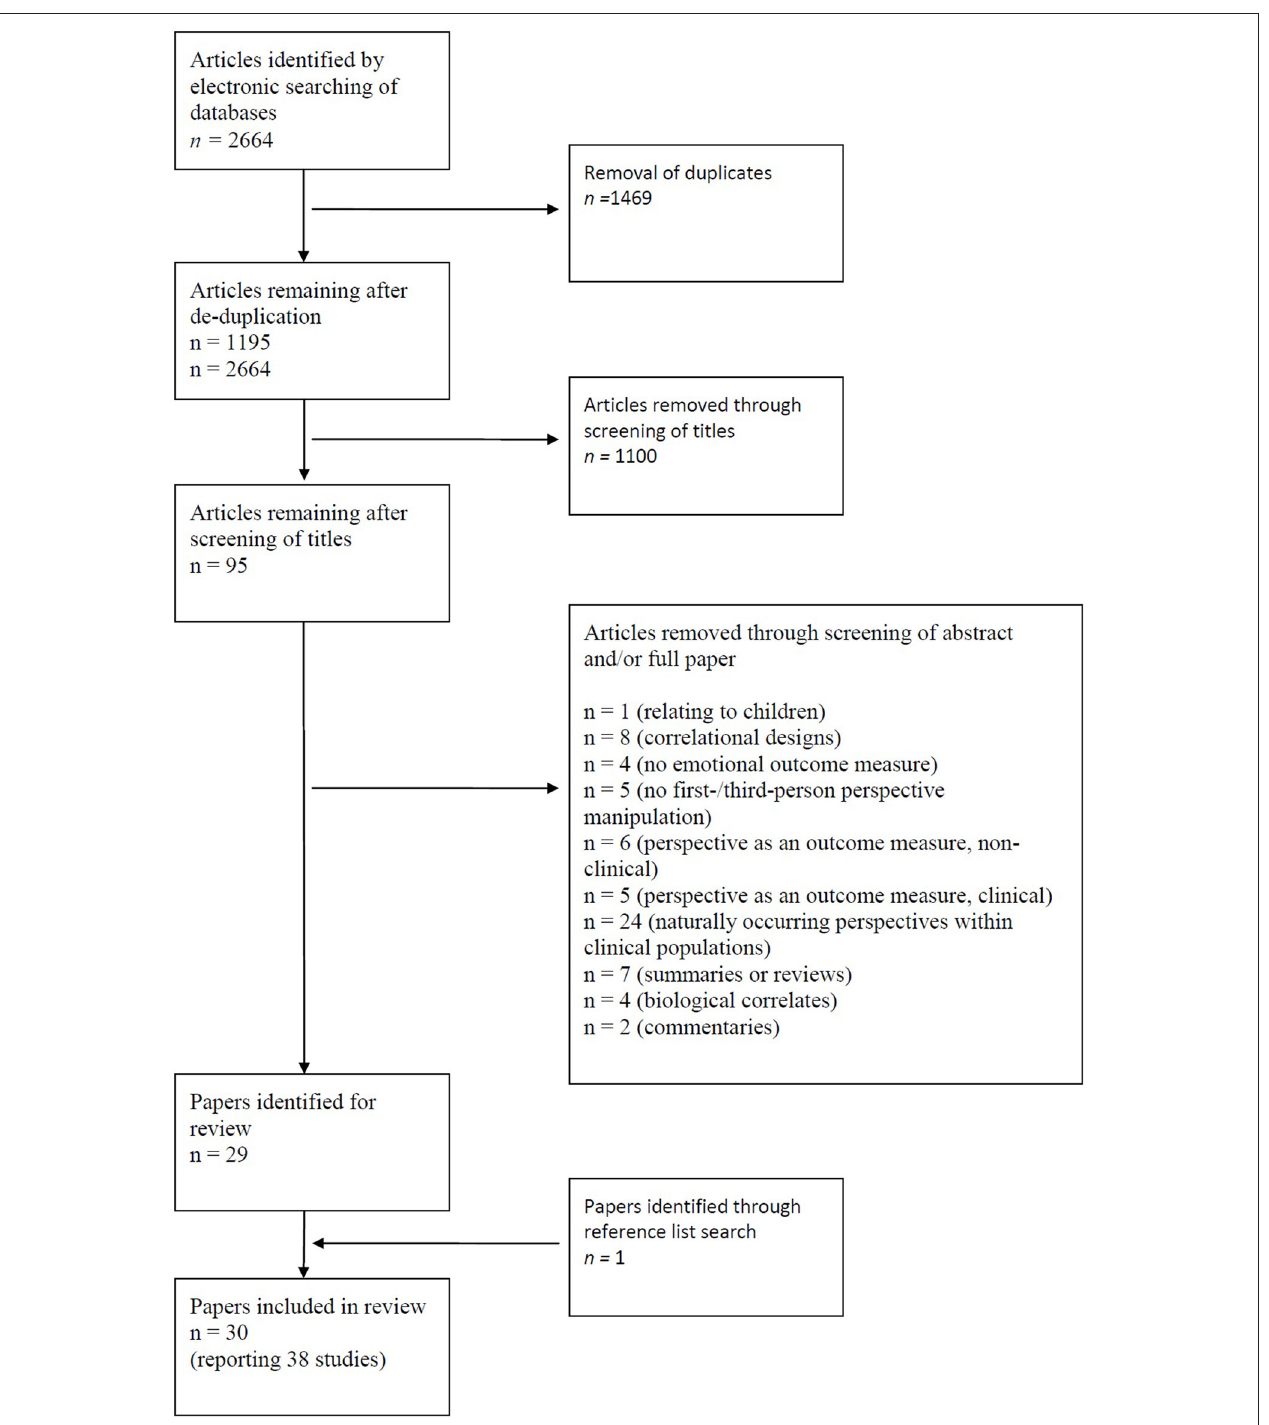
FIGURE 1 | Flowchart of literature search process.